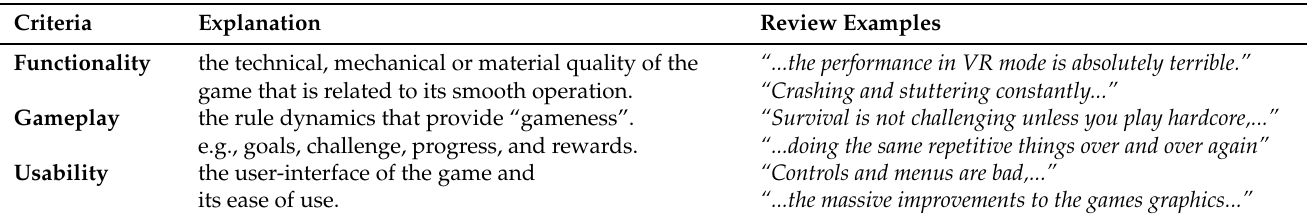
Table 1. “Playability-informative” Criteria based on Paavilainen’s Framework [8] and Examples.